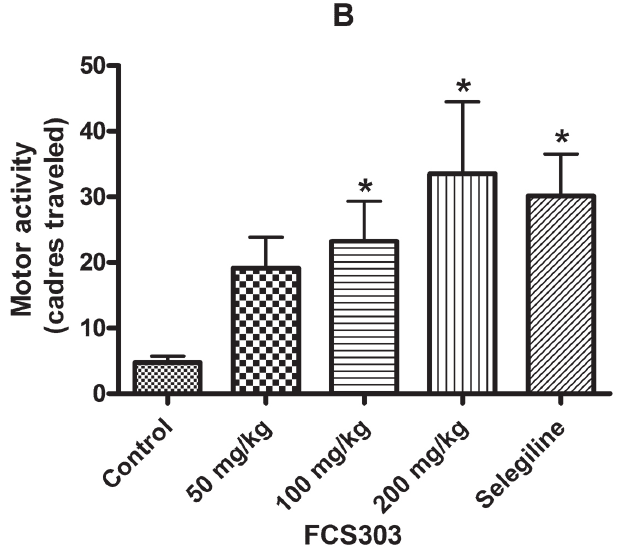
whereas no difference was detected at 2 h (Figure 3A).